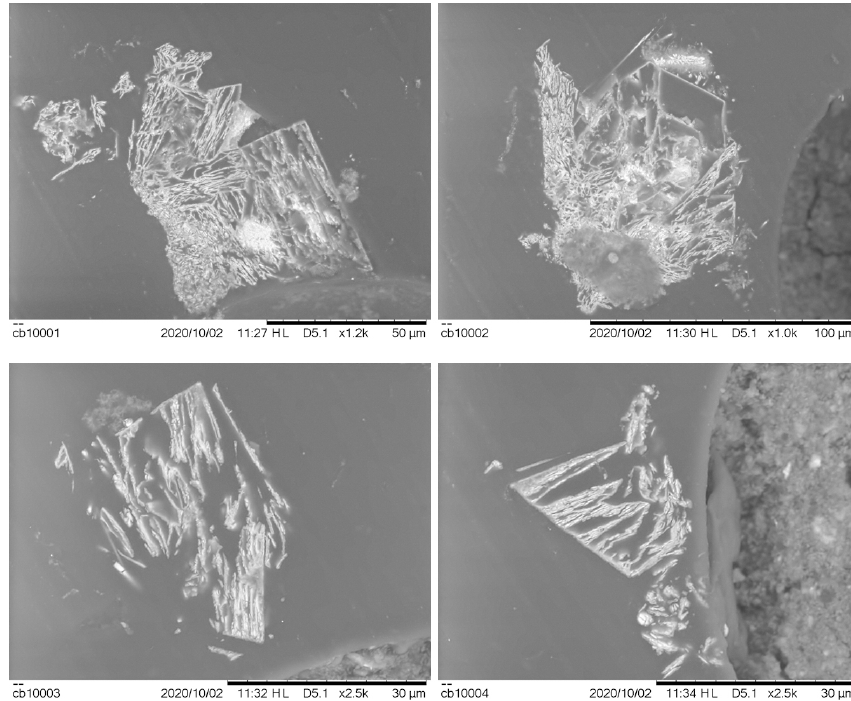
Figure 2. Backscattered electron images of polished crystals of graulichite-(La) embedded in epoxy, showing their porous nature.